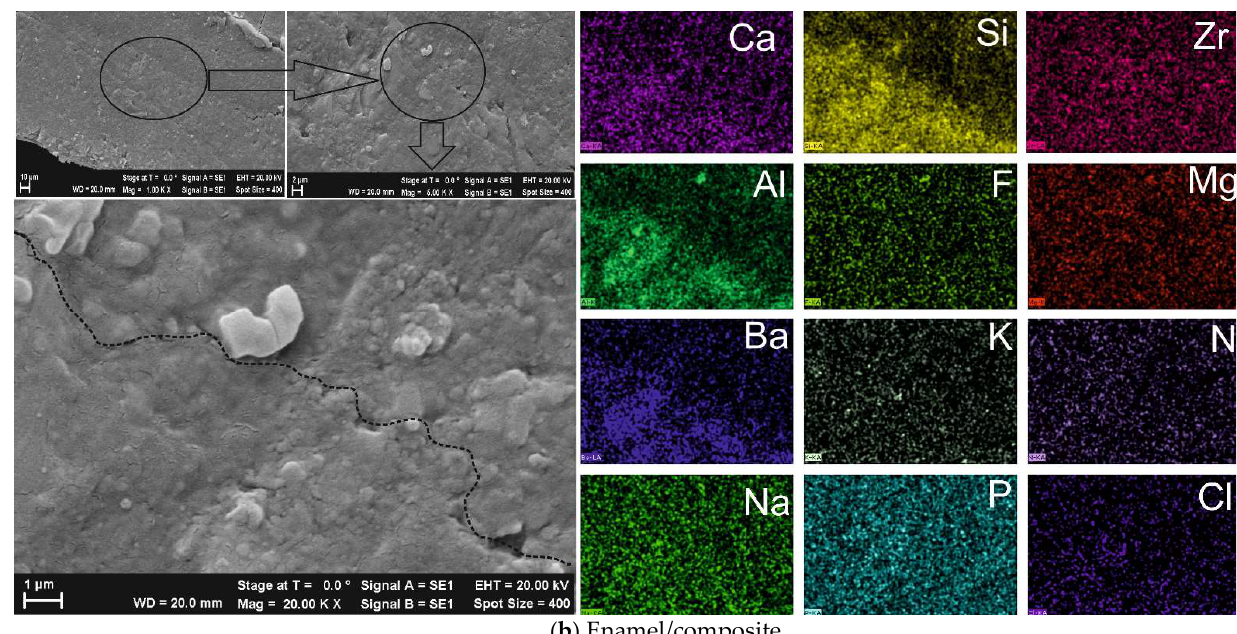
Figure 2. EDX measurements of the dentin/composite border ( a ) and enamel/composite border ( b ).